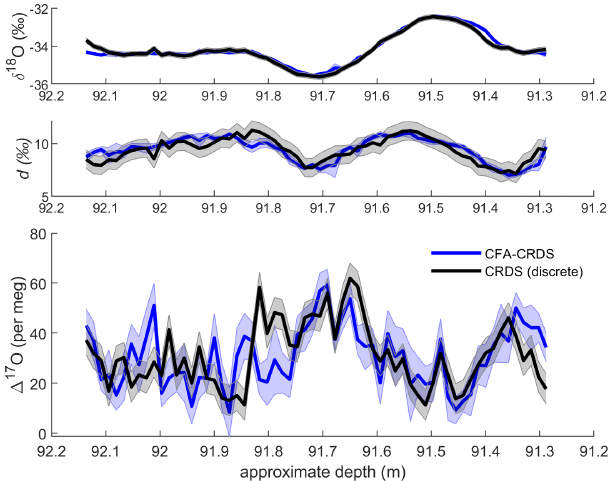
Figure 4. Comparison of discrete CRDS ice-core measurements (black) with calibrated CFA–CRDS data averaged over 1.39cm in- tervals (blue). Corresponding δ 18 O and d data are shown for sea- sonal context. Discrete CRDS measurements are shown with the root mean square error of corresponding reference water measure- ments (grey shading), and CFA–CRDS measurements are shown as the mean of nine measurements with the standard error (blue shad- ing). Note that δ 18 O and d are reported in ‰ and that (cid:49) 17 O is measured in per meg; each vertical axis uses different